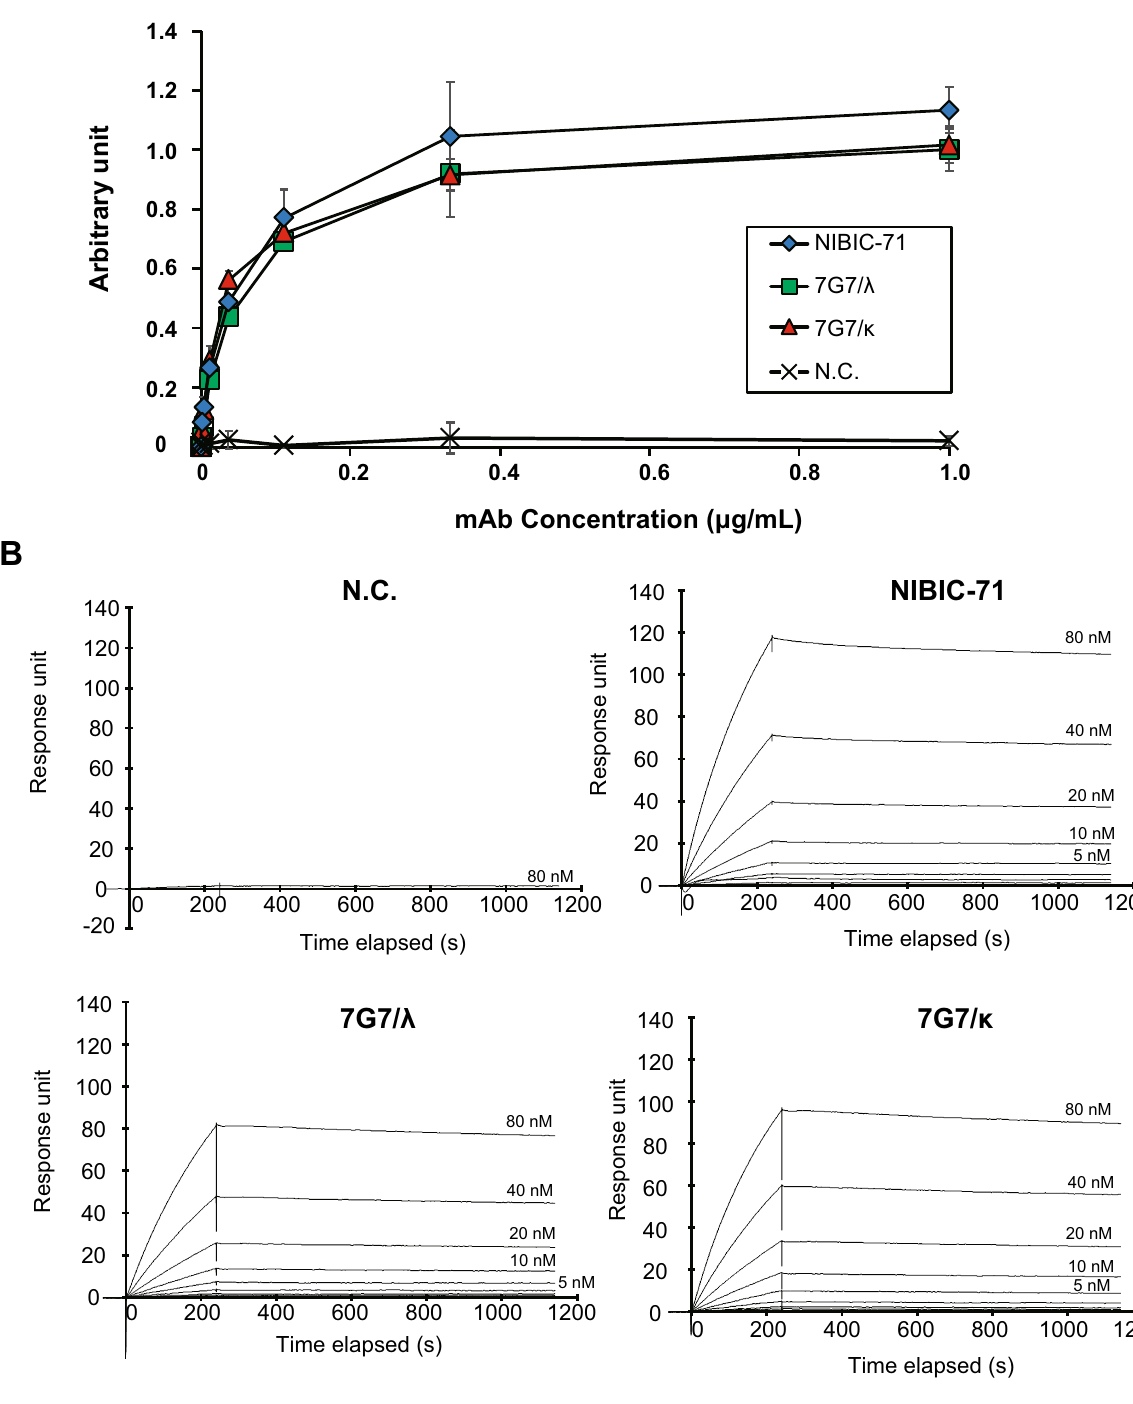
Figure 2. Binding affinity of NIBIC-71 and 7G7 to the S protein. ( A ) The ability to bind to the S protein was evaluated with ELISA and serially diluted recombinant mAbs from 10 to 0.001 µg/mL in triplicate. Blue diamonds indicate NIBIC-71, green squares indicate 7G7/λ, red triangles indicate 7G7/κ, and cross markses indicate negative control mAb (N.C.). ( B ) SPR analyses for these mAbs. The SPR sensorgrams were obtained by injecting twofold serial dilutions of the S protein ranging from 80 to 0.625 nM for NIBIC-71, 7G7/λ, and 7G7/κ. Contact time and dissociation time were set as 240 s and 900 s, respectively. The kinetic values are shown